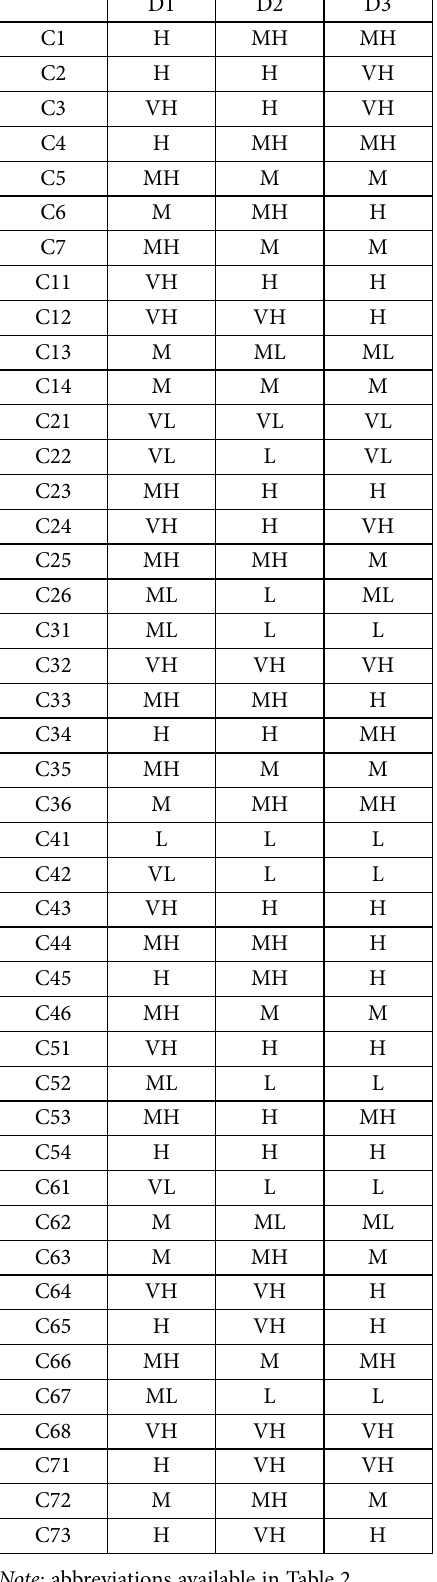
Table 3. Importance weight of the criteria assessed by decision makers (linguistic values)